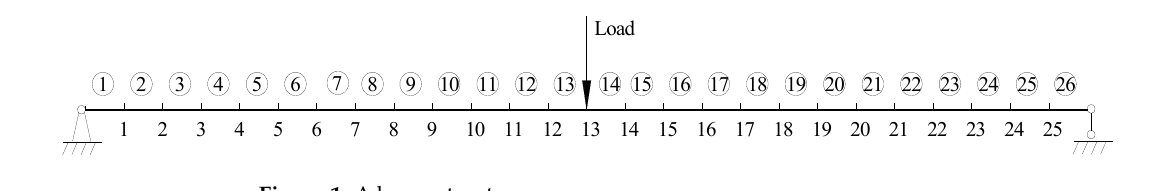
Figure 1. A beam structure.